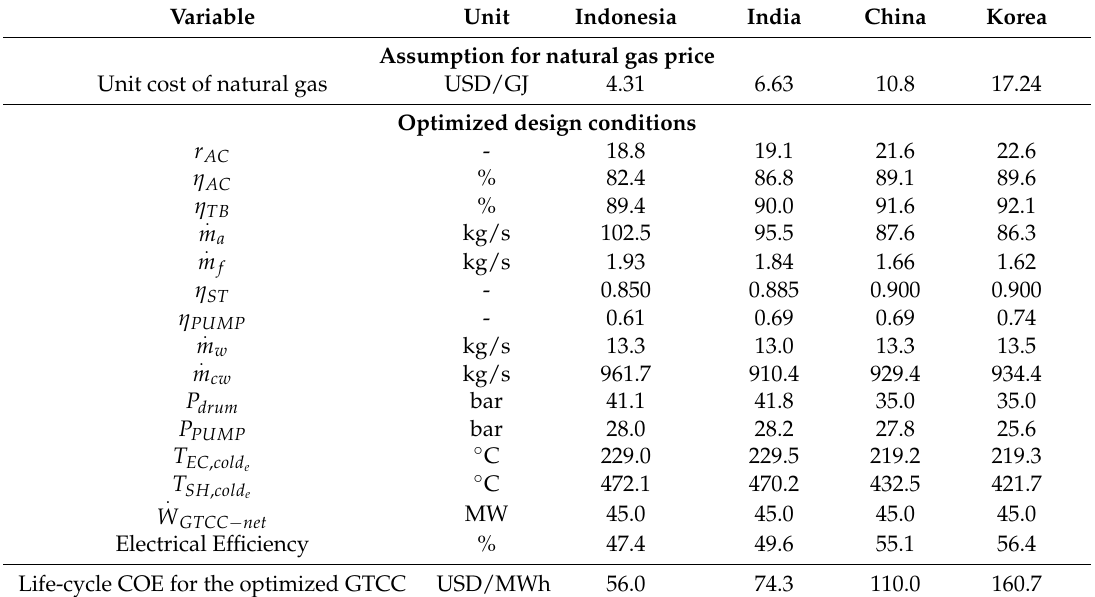
Table 11. Optimized design conditions of gas turbine combined cycle (GTCC) with different fuel